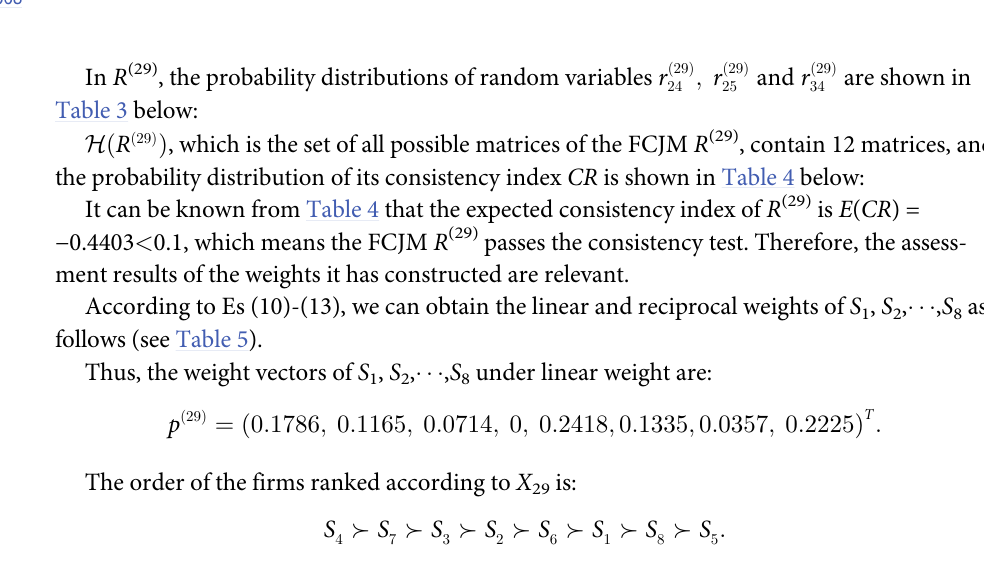
When calculating the utility function of quantitative indicators, we assume that α = 1/2. Thus, we can obtain the weight vectors of S , S , � � � , S under all 31 assessment indicators as 1 2 8 p (1) , p (2) , p (3) , � � � , p (31) . See Table 1 in S1 Appendix for specific data. To obtain the weight vec- tors of X , X , � � � , X , which belong to the system of indicators for assessing firms’ own credit 1 2 31 risk in the automotive supply chain, we now construct the preference relation matrix R of the X assessment indicators (see S1 Appendix). If its maximum eigenvalue λ = 15.1085, and con- Max sistency index CR = − 0.3332 < 0.1, then R passes the consistency test. We then use the eigen- X vector method to obtain the weight vectors of the assessment indicator system: